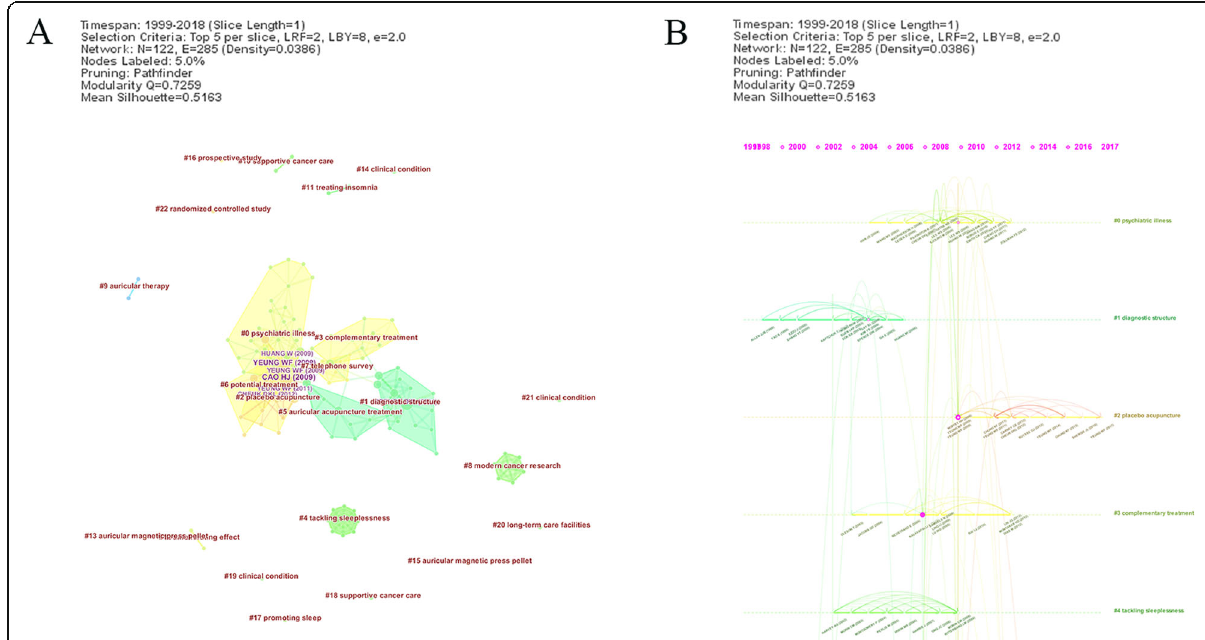
Fig. 4 Cited reference map of acupuncture for insomnia. a The network map of cited reference related to acupuncture for insomnia. b The timeline view of cited reference related to acupuncture for insomnia